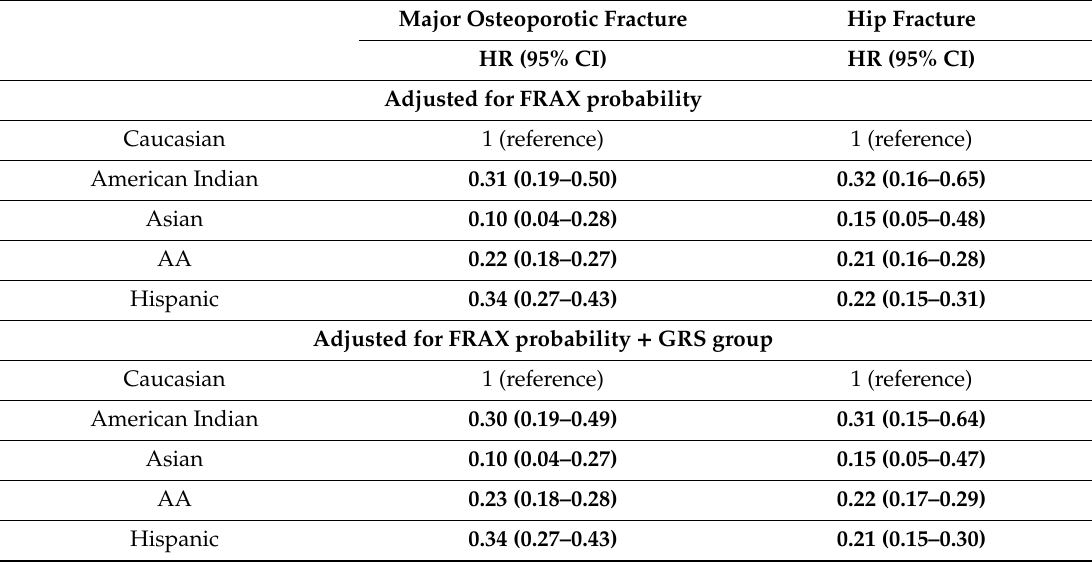
Table A2. Hazard ratios (HR) with 95% confidence interval (CI) for outcomes of Incidence fracture according to the GRS group, adjusted for FRAX score: results from sensitivity analysis after excluding subjects who received intervention in either of the three clinical trials. ( n = 14,722).